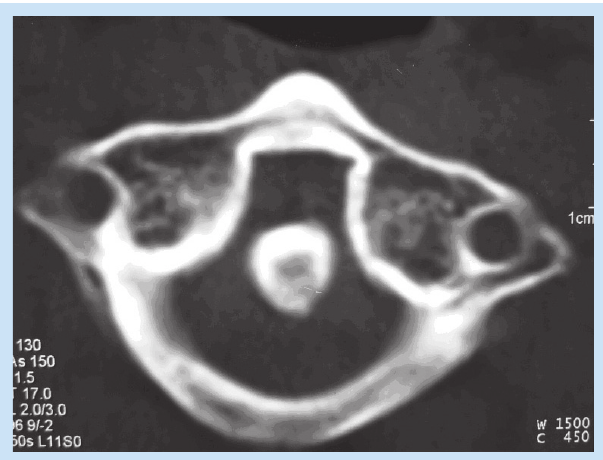
Fig. 4. Axial CT demonstrating the increased ADI.